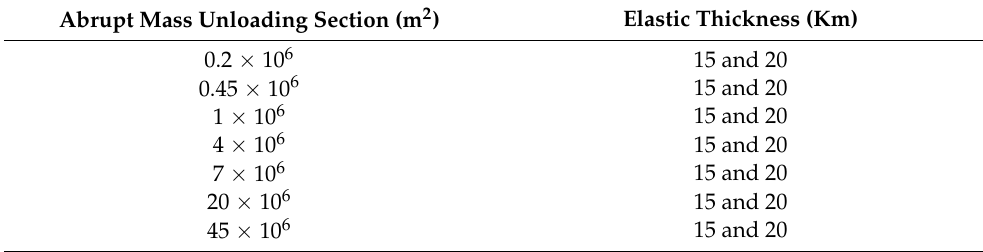
Table 1. Parameters for abrupt mass unloading and flexure